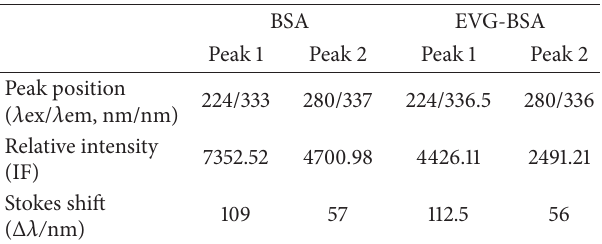
Table 4: Three-dimensional fluorescence characteristic parameters of EVG-BSA